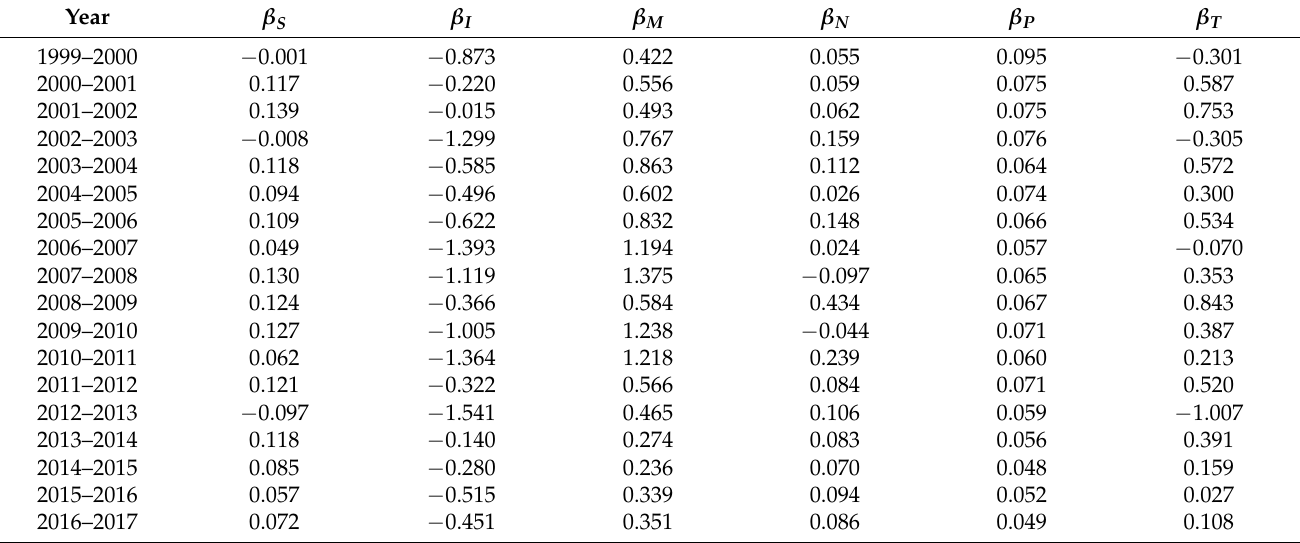
Figure 7. Changes in the total decoupling index and the sub-decoupling index in Ningxia from 1999 to 2017. Table 4. The decoupling index of different land capital use and GDP